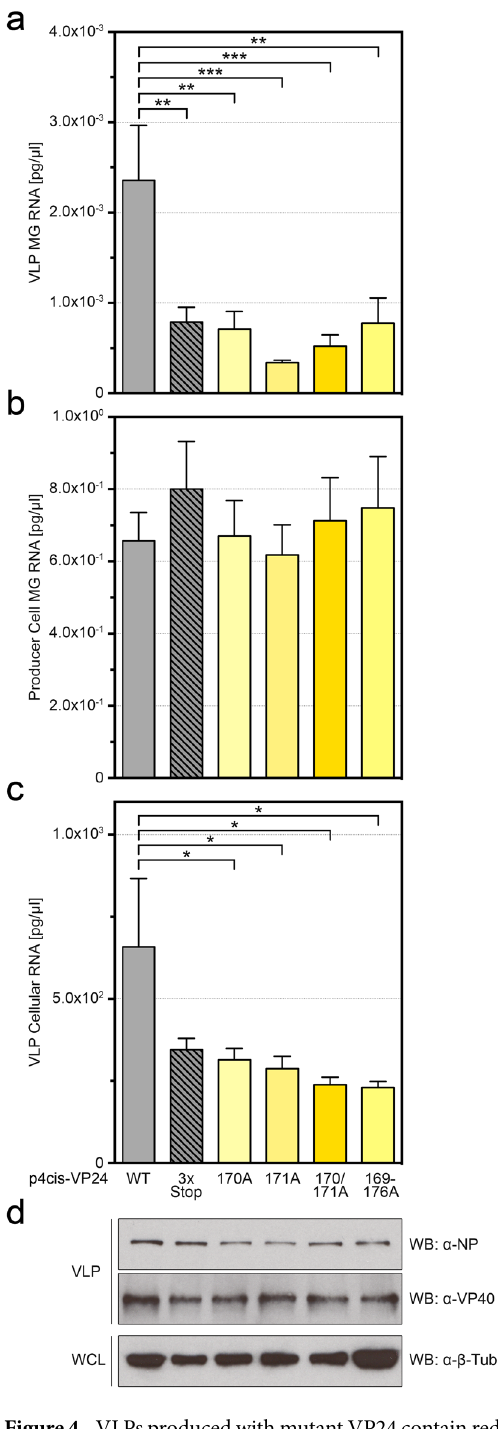
Figure 4. VLPs produced with mutant VP24 contain reduced levels of EBOV minigenome. ( a – d ) HEK 293 cells were co-transfected with p4cis-vRNA-RLuc, encoding wild-type (WT) VP24, VP24-3x-stop, VP24 V170A, VP24 N171A, VP24 V170A/N171A or VP24 169–176A, as well as pCAGGS-T7, pCAGGS-L, pCAGGS-NP, pCAGGS-VP35, and pCAGGS-VP30. Supernatant was concentrated and virus-like particles (VLPs) were purified over a 20% sucrose cushion via ultracentrifugation. Following lysis of purified VLPs, viral minigenome RNA was purified and quantified via RT-qPCR ( a ) or total cellular RNA was quantified using a Low Abundance RNA Quantification kit ( c ). Producer cells were lysed, and viral minigenome RNA was purified and quantified via RT- qPCR ( b ). Data are presented as pg/ul EBOV minigenome RNA isolated from VLPs ( a ) or producer cells ( b ) or as pg/ul total cellular RNA isolated from VLPs ( c ). The means and standard error of the mean for 5 independent experiments are shown ( * p ≤ 0.05; ** p ≤ 0.01; *** p ≤ 0.001). VLP lysates and producer cell whole cell lysates (WCL) were subjected to Western blot (WB) with mouse anti-NP, rabbit anti-VP40, and rabbit anti- β -tubulin antibodies ( d ). Western blots were cropped for presentation; full-length blots are available in Supplementary Fig.